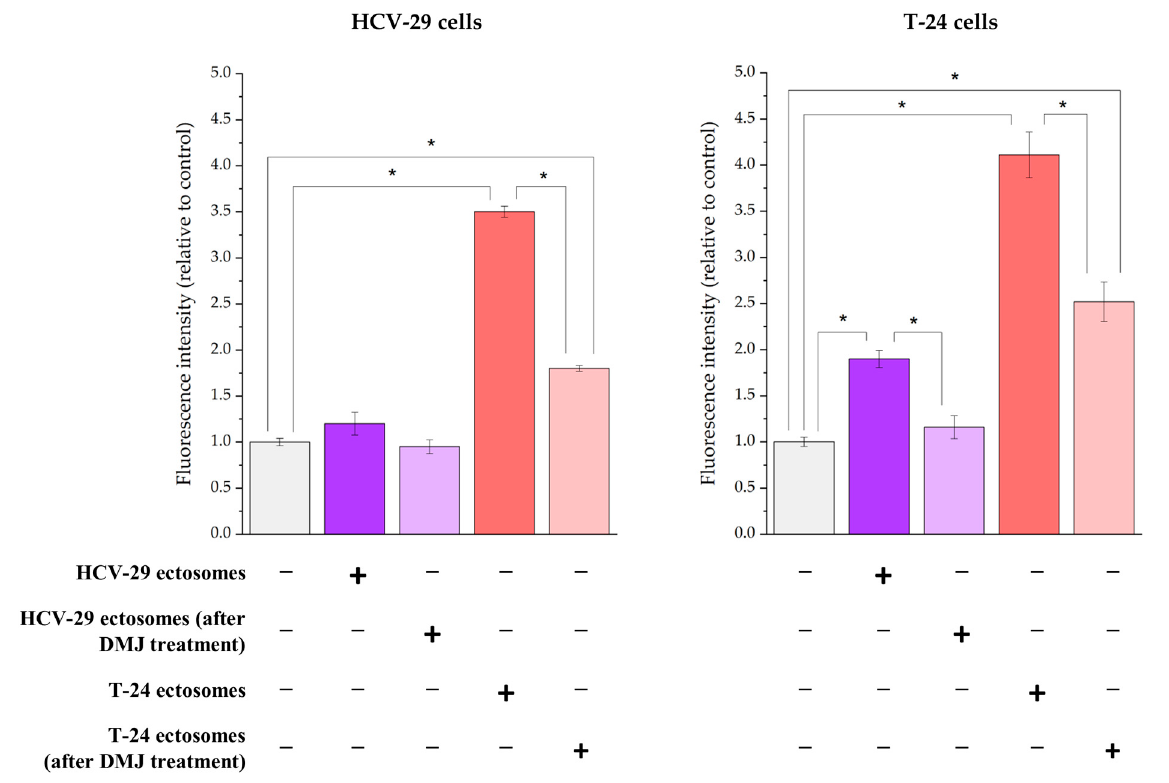
Figure 15. Effect of incubation of HCV-29 normal ureter epithelial cells ( left panel ) and T-24 urothelial bladder carcinoma cells ( right panel ) with ectosomes released by these cell lines without or after DMJ treatment on cell viability. Alamar Blue cell viability assay was carried out after 18 h of incubation with ectosomes. All experiments were conducted in triplicate. “*” denotes statistically significant differences (Tukey’s post-hoc test, p -value < 0.05).